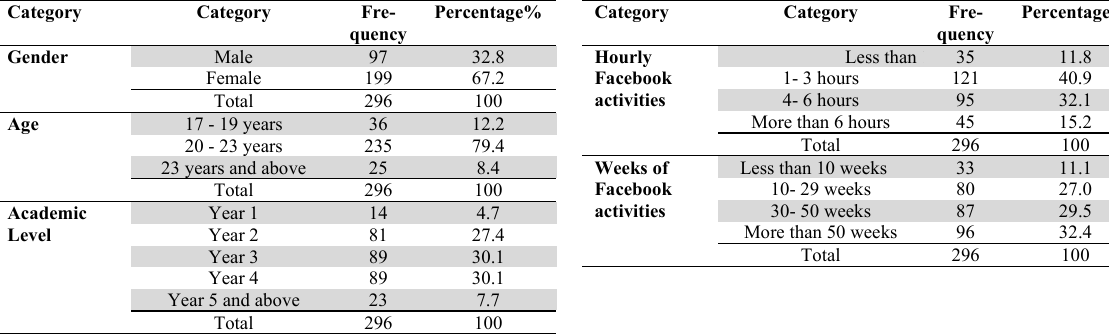
Characteristics of the research sample (n=